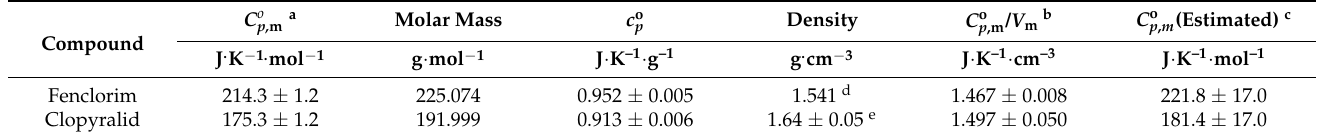
Table 4. Experimental and estimated crystalline standard molar heat capacities C o p , m , specific heat capacities, c o p , densities and volumetric heat capacities, C o p , m / V m , at T = 298.15 K of fenclorim and clopyralid.